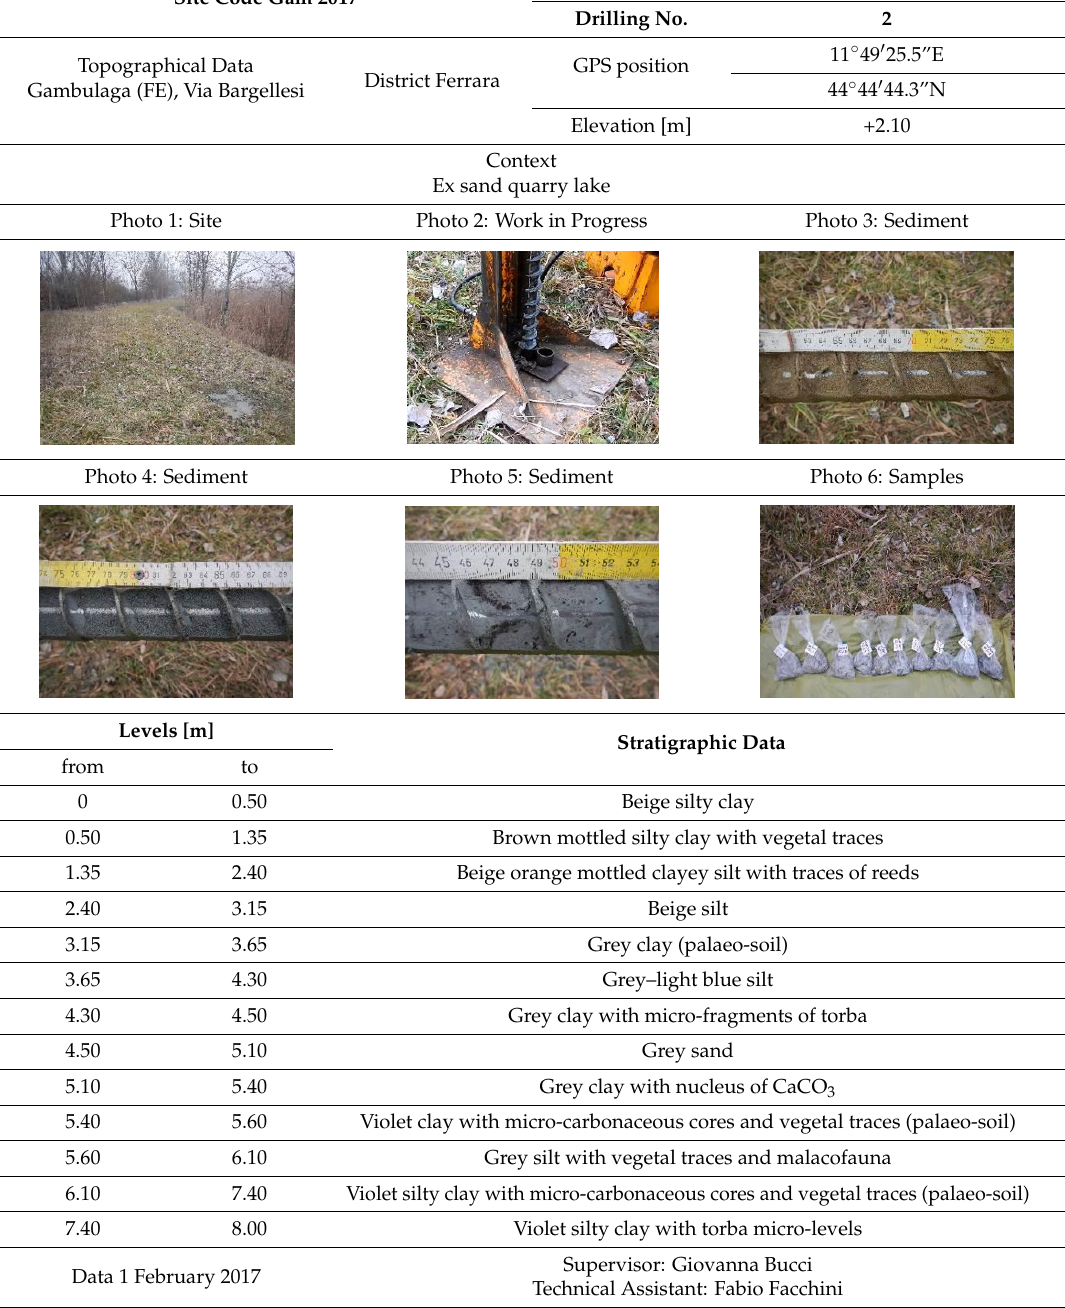
(FE, Italy). Table A2. Drilling No. 2.